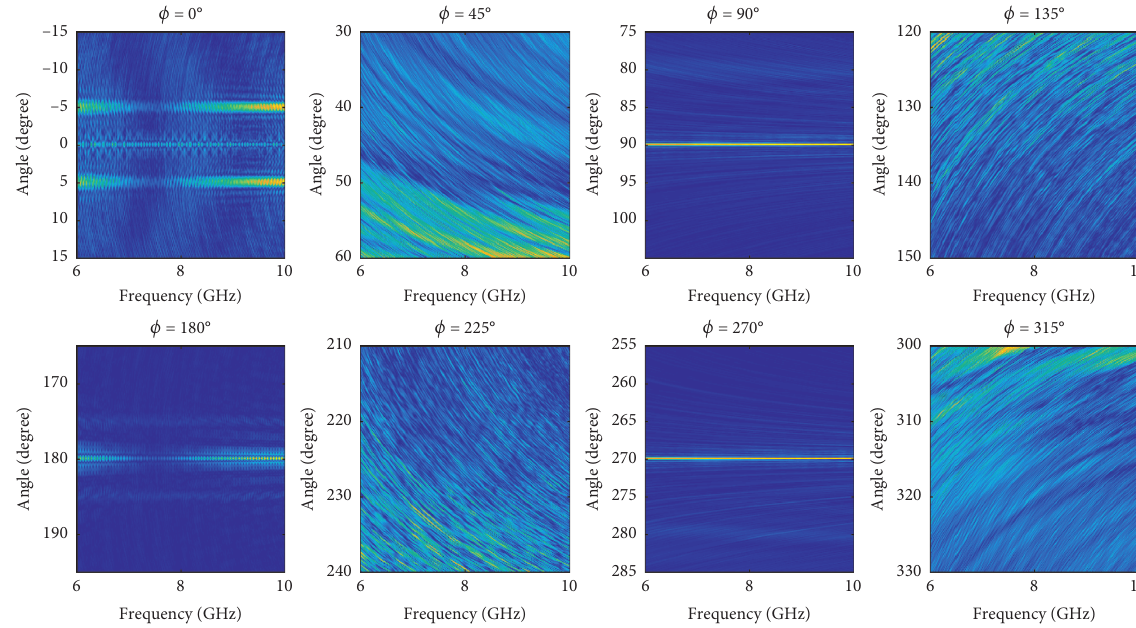
Figure 10: The backward scattering data in spatial-frequency domain.